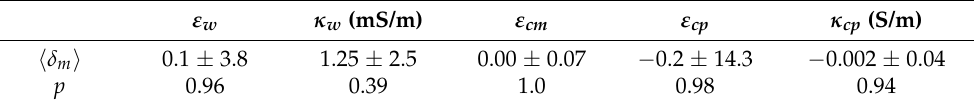
Figure 4. Typical plots of the ( a ) relative permittivity and ( b ) conductivity of yeast cells suspended in a 0.02 M KCl (squares) and yeast cells suspended in a 0.02 M KCl solution containing sorbitol (circles). The concentration of sorbitol in solution was 250 μ M in order to replicate the osmotic pressure felt by yeast cells exposed to the same concentration of α -factor. The theoretical best fit to the measured data predicted by the three-shell model presented in the text is represented by the solid lines. The dashed lines represent the theoretical fit with the correction due to the electrode polarization subtracted off. Fitting parameters used in simulation of measured spectra for cells in the presence of sorbitol: d cm = 2.50 nm, d om = 2.50 nm, R = 1.65 µ m, R 0 = 1.25 µ m, v = 0.18, ε a = 78.0, κ a = 0.26 S/m, ε w = 83.5, κ w = 0.035 S/m, ε cm = 2.52, κ cm = 0 S/m, ε cp = 39.8, κ cp = 0.25 S/m, ε om = 11.8, κ om = 0 S/m, ε io = 60.1, κ io = 1.65 S/m, a = 1.41 × 10 5 , b = 0.81. Fitting parameters used in simulation of measured spectra for cells not exposed to sorbitol: d cm = 2.50 nm, d om = 2.50 nm, R = 1.65 µ m, R 0 = 1.25 µ m, v = 0.18, ε a = 78.0, κ a = 0.26 S/m, ε w = 86.6, κ w = 0.035 S/m, ε cm = 2.51, κ cm = 0 S/m, ε cp = 38.9, κ cp = 0.24 S/m, ε om = 11.6, κ om = 0 S/m, ε io = 41.2, κ io = 1.63 S/m, a = 1.46 × 10 5 , b = 0.81. Table 3. Average difference between electrical phase parameters, plus or minus one standard deviation, (n = 4 experiments) along with the p -value obtained by applying a paired Student’s t -test to pairs of Ste2 ∆ cell suspensions suspended in electrolytic solution with and without Sorbitol added to it. ε